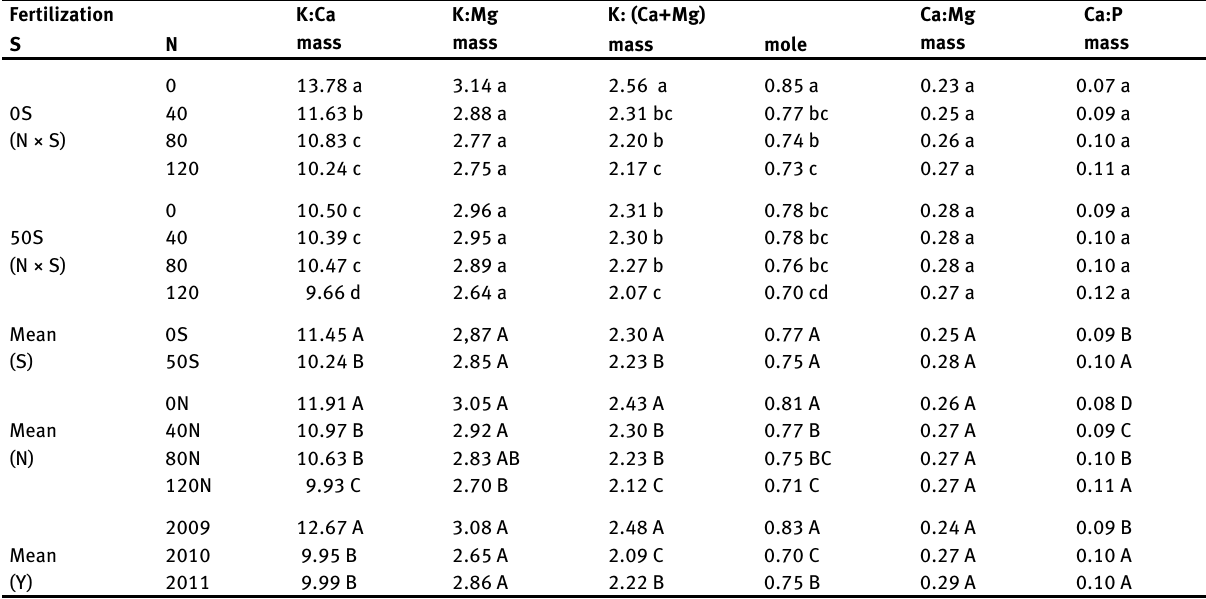
Table 4: Ratios of macronutrients in the grain of spring wheat.